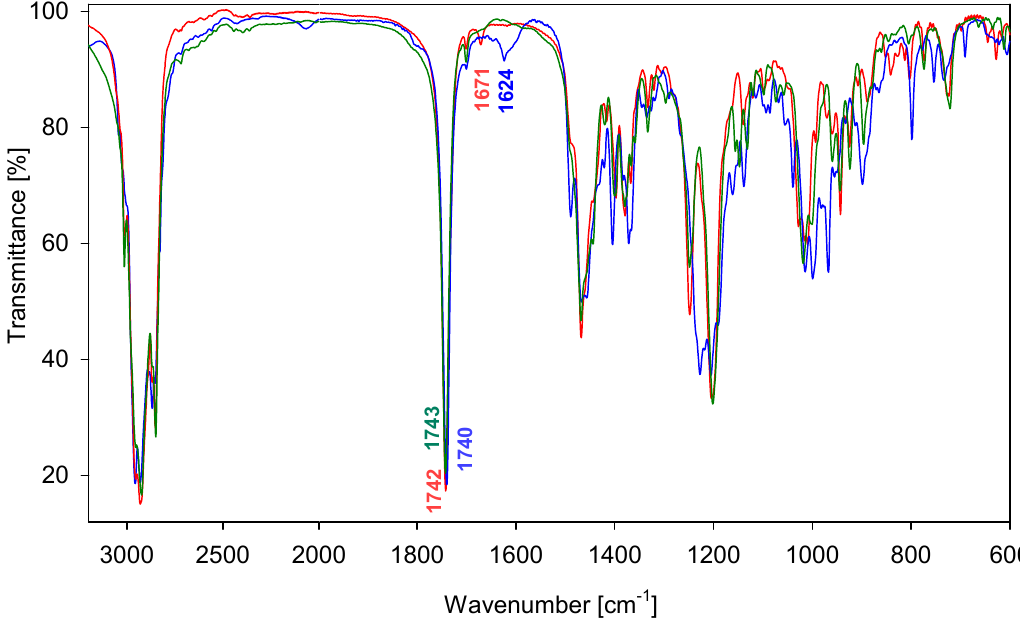
Figure 5. FT-IR spectra of conjugates 9 (blue), 13 (red) and 17 (green) in the 3,000–600 cm − 1 region.